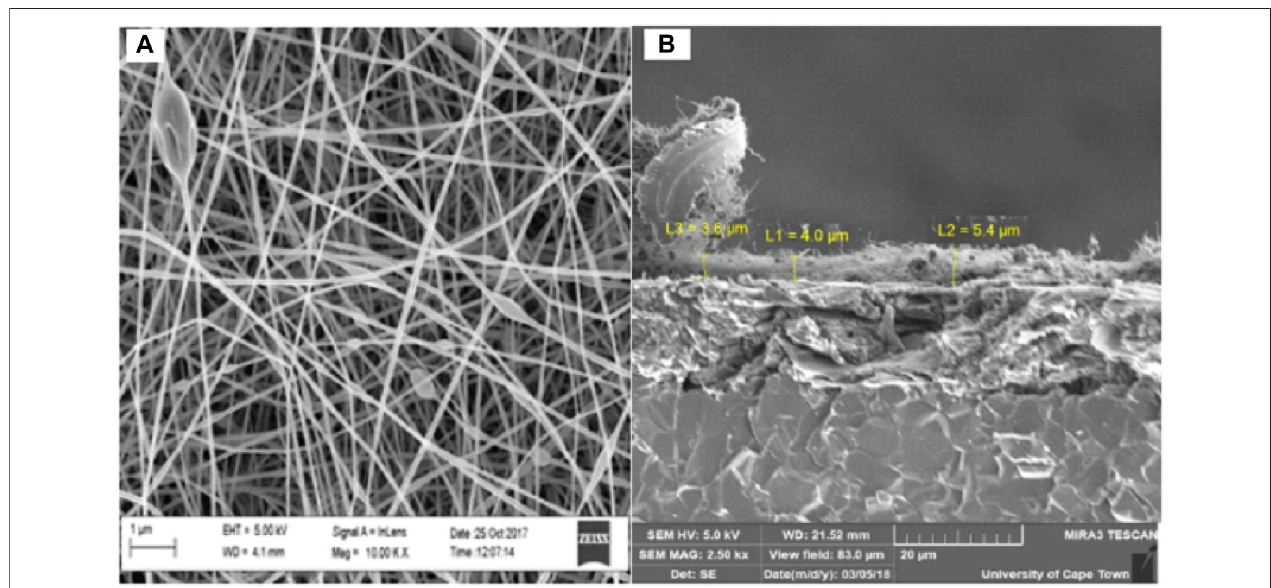
FIGURE 3 | HRSEM (A) at 100,00x and cross-sectional SEM (B) at 5,000x images of PAA nano fi bers.